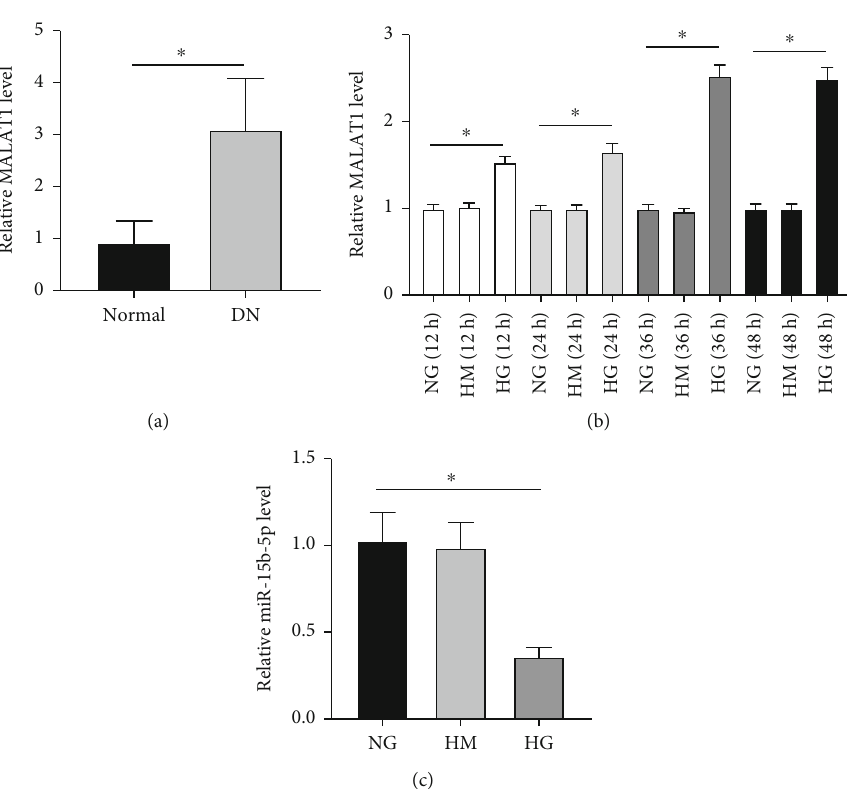
Figure 1: MALAT1 and miR-15b-5p expression in DN tissues and HK-2 cells treated with NG, HM, or HG. (a) qRT-PCR analysis of MALAT1 in DN tissues. ∗ p < 0 : 05 versus the NG group. (b) qRT-PCR analysis of MALAT1 in HK-2 cells treated with NG, HM, or HG after 12, 24, 36, or 48 h. ∗ p < 0 : 05 versus the NG group. (c) qRT-PCR analysis of miR-15b-5p in HK-2 cells treated with NG, HM, or HG. ∗ p < 0 : 05 versus the NG